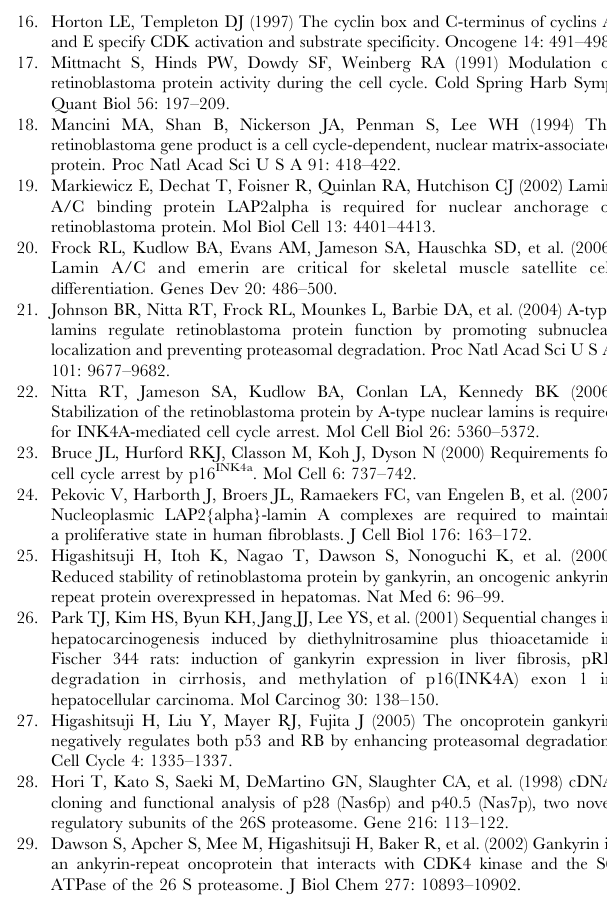
Figure S1 Overexpression of gankyrin leads to pRB degradation by the proteasome in U2OS cells. U2OS cells were stably transduced with gankyrin-V5 or a vector control and were treated with a proteasome inhibitor (MG132) and/or cycloheximide (CHX) for the specified times. Protein samples were separated by a 8% SDS PAGE and detected by immunoblot with mouse anti-